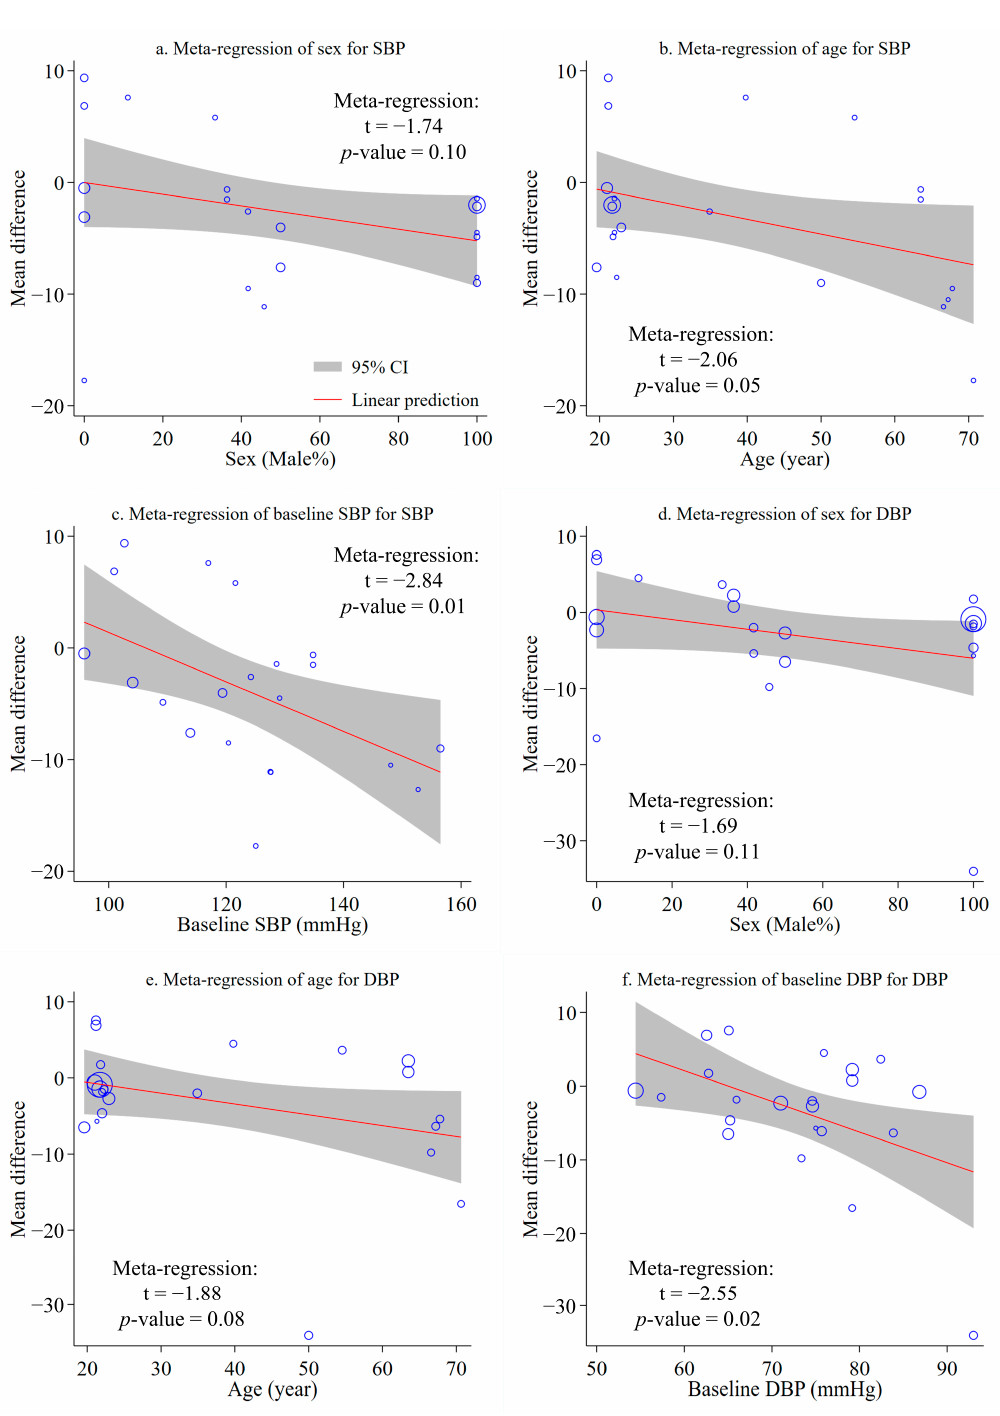
Figure 4. Bubble plots and meta-regressions for visual assessments of the effects of sex, age, and baseline blood pressure on the mean difference between SBP and DBP. Blue symbols indicate in- cluded studies.